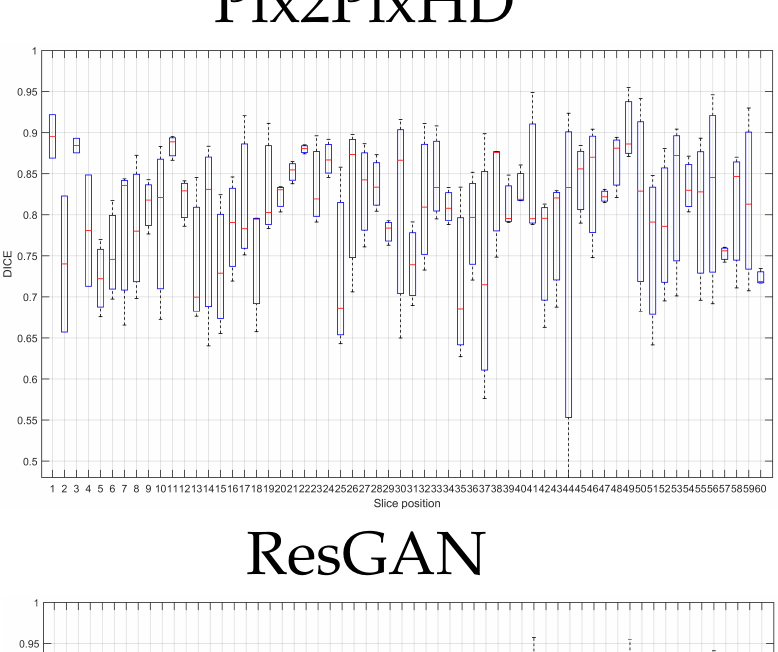
Figure 10. Segmentation test set DICE results by slice position.